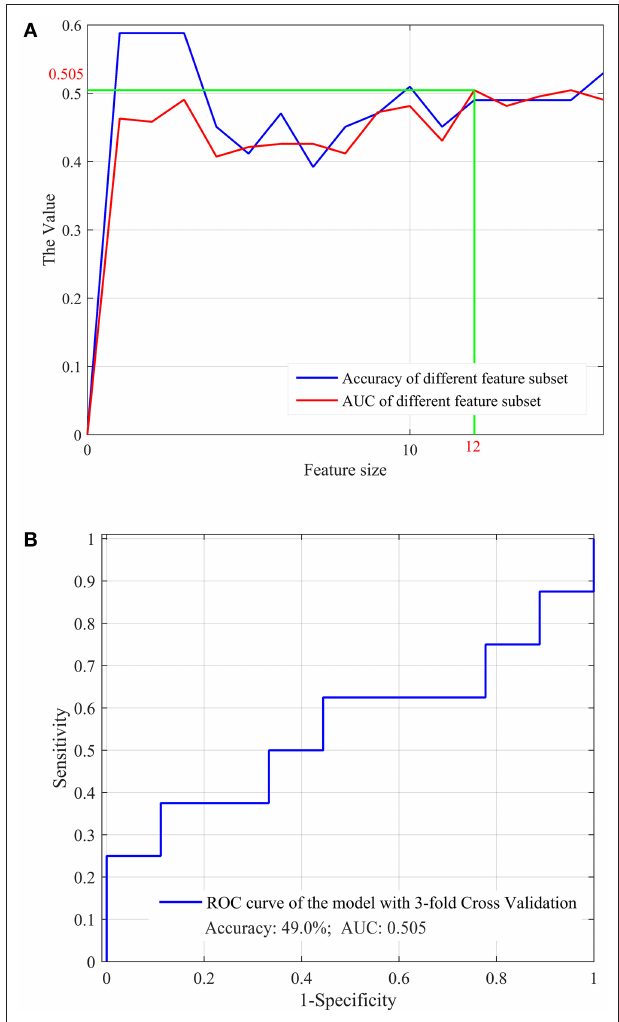
FIGURE 3 | The optimal feature subset selected from the clinical factors (A) and the overall performance (B) for the prediction of the re-positive cases.